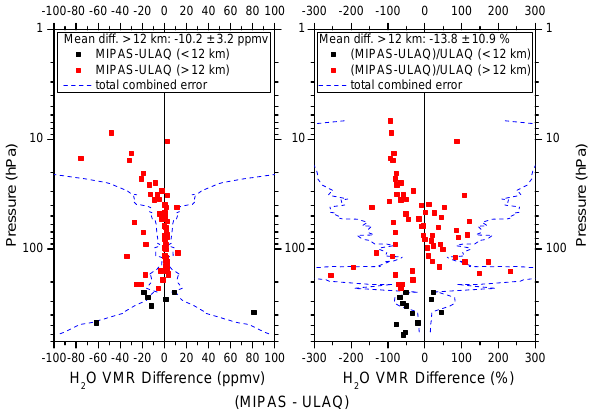
Fig. 18. Differences between H 2 O profiles measured by MIPAS and thirteen radio soundings of the University of L’Aquila (smoothed with the MIPAS averaging kernel above 12 km and with a boxcar function below 12 km), performed in winter/spring 2002 and 2004, together with combined total errors (blue dashed lines). Black squares: differences below 12 km; red squares: differences above 12 km.